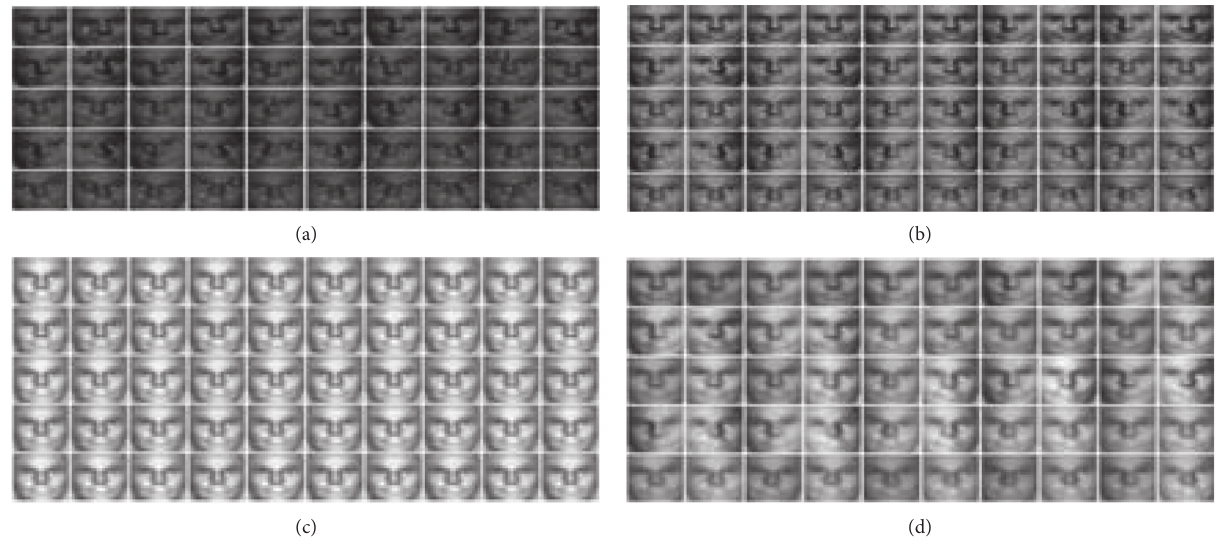
Figure 2: Some recovered dummy face images. (a) Original, (b) NQLSD, (c) RASL, and (d) proposed method.